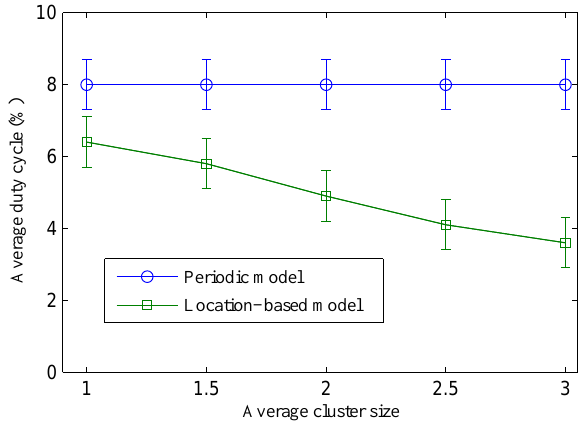
Figure 3. Average energy consumption under various cluster sizes.